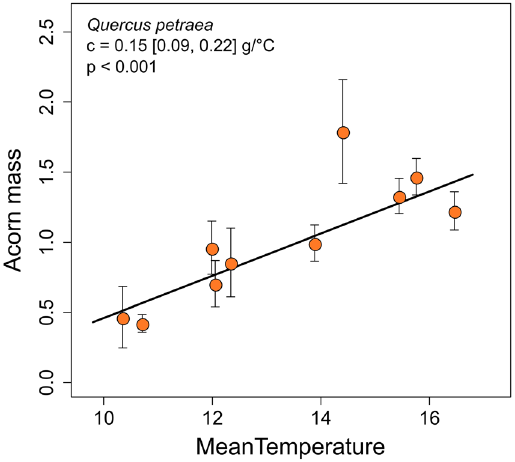
Figure 3. Temperature trends in seed mass for Quercus petraea . Trend in acorn mass (g) with mean temperature from April to November (°C) along the elevation gradient. Each dot corresponds to the mean acorn mass, across years and trees, per population along the elevation gradients. The slope of the regression line and its 95% confidence interval, calculated from a linear mixed-effects model, and the coefficient of determination ( R 2 ) are indicated. April to November corresponds to reproductive cycle length in Q . petraea : from flowering to acorn